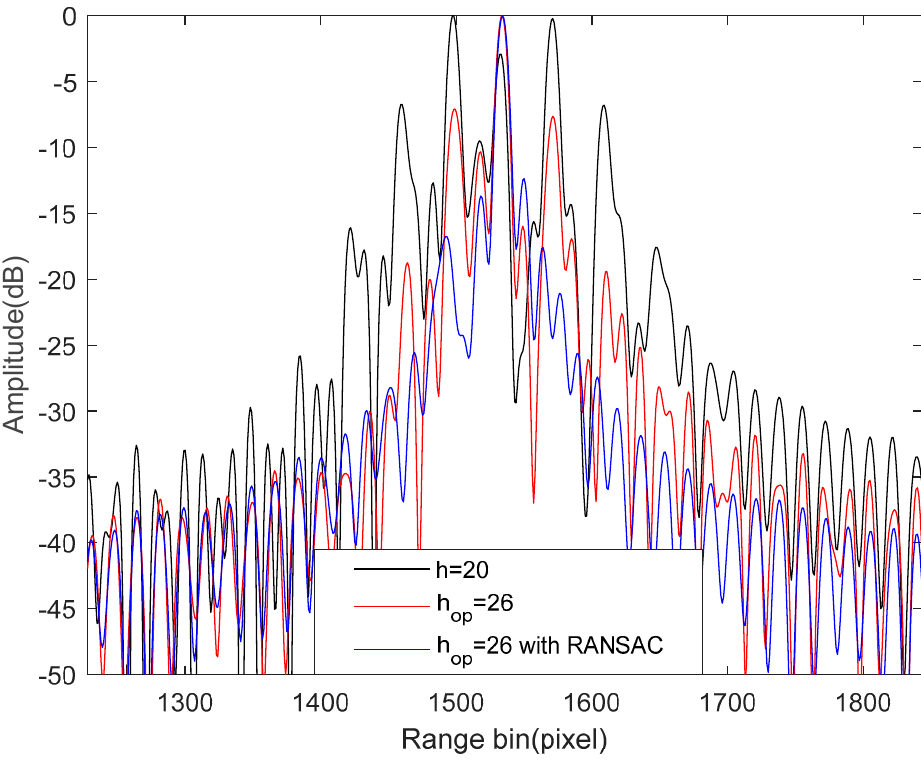
Figure 8. Azimuth-dimensional amplitude profiles of center-point target. Table 3. Imaging quality evaluation after vibration error compensation .